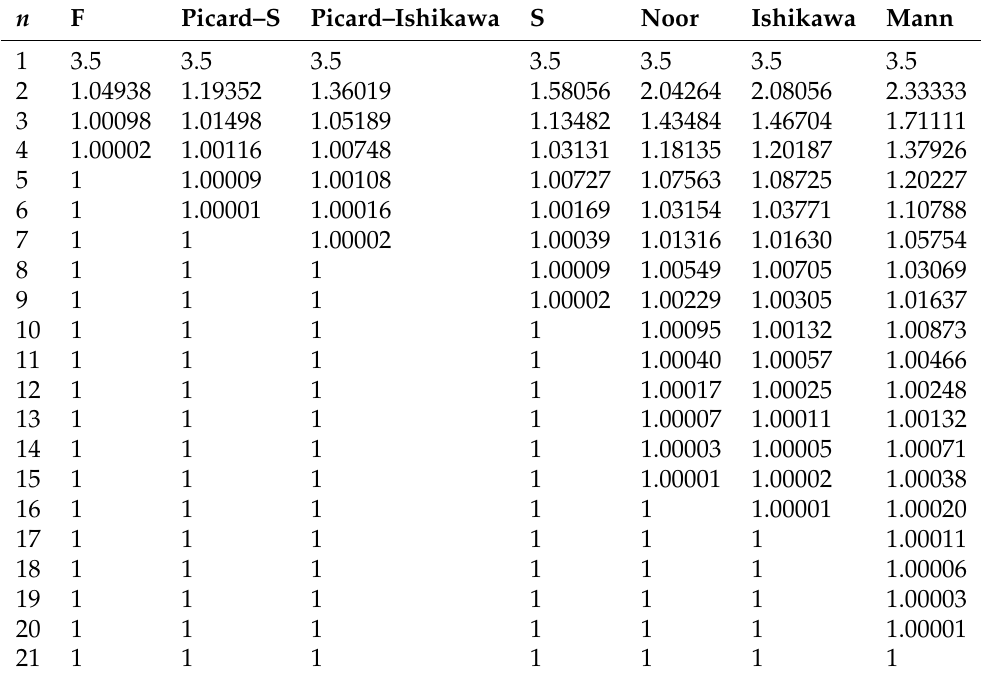
Table 2. Some iterates suggested by the F , Picard–S, Picard–Ishikawa, S, Noor, Ishikawa, and Mann methods for T given in Example